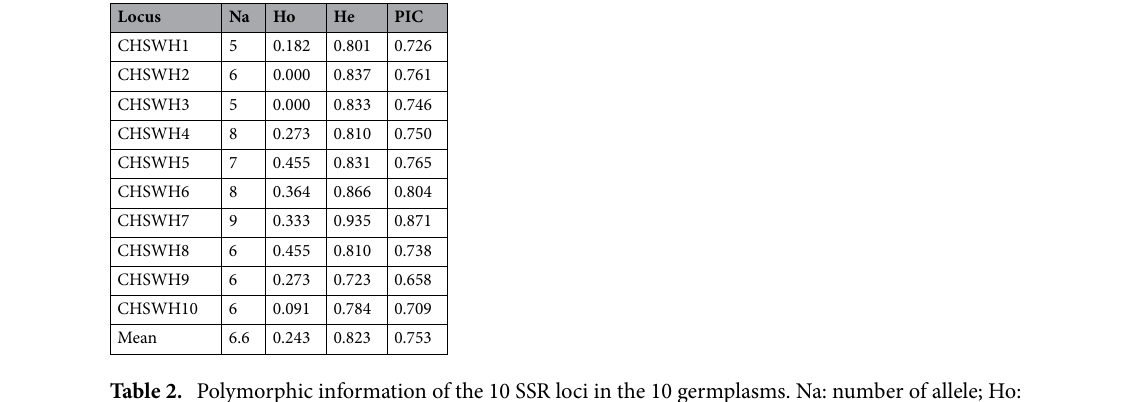
Table 2. Polymorphic information of the 10 SSR loci in the 10 germplasms. Na: number of allele; Ho: observed heterozygosity; He: expected heterozygosity; PIC: polymorphism information content.